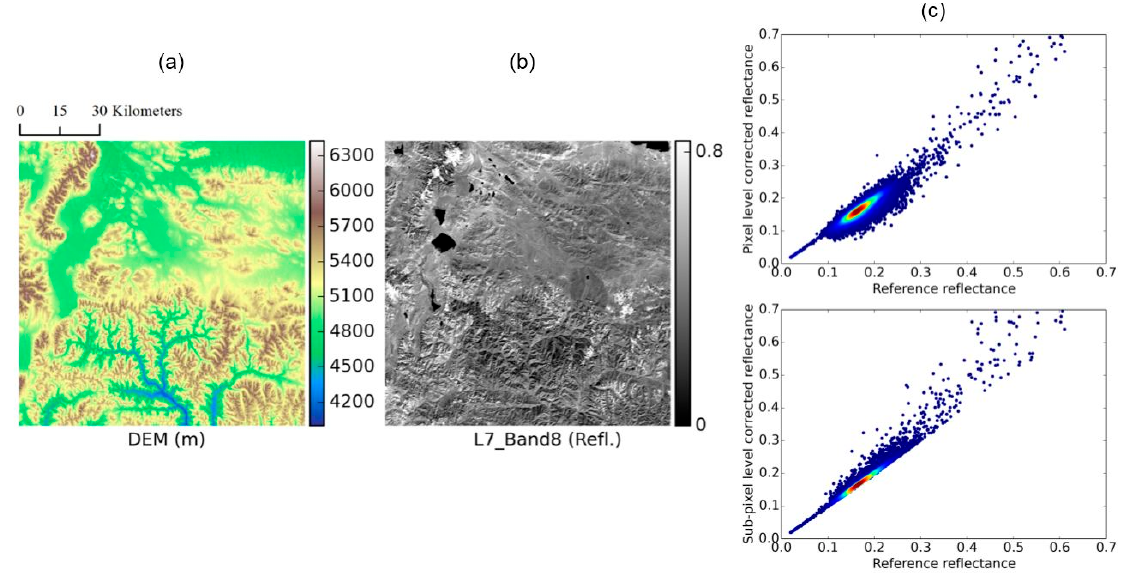
Figure 12. ( a ) Study site DEM, ( b ) Corresponding Landsat-7 scene and ( c ) Difference between reference reflectance and pixel ( top ) or sub-pixel ( bottom ) topographically corrected reflectance for the band 8 of Landsat-7.